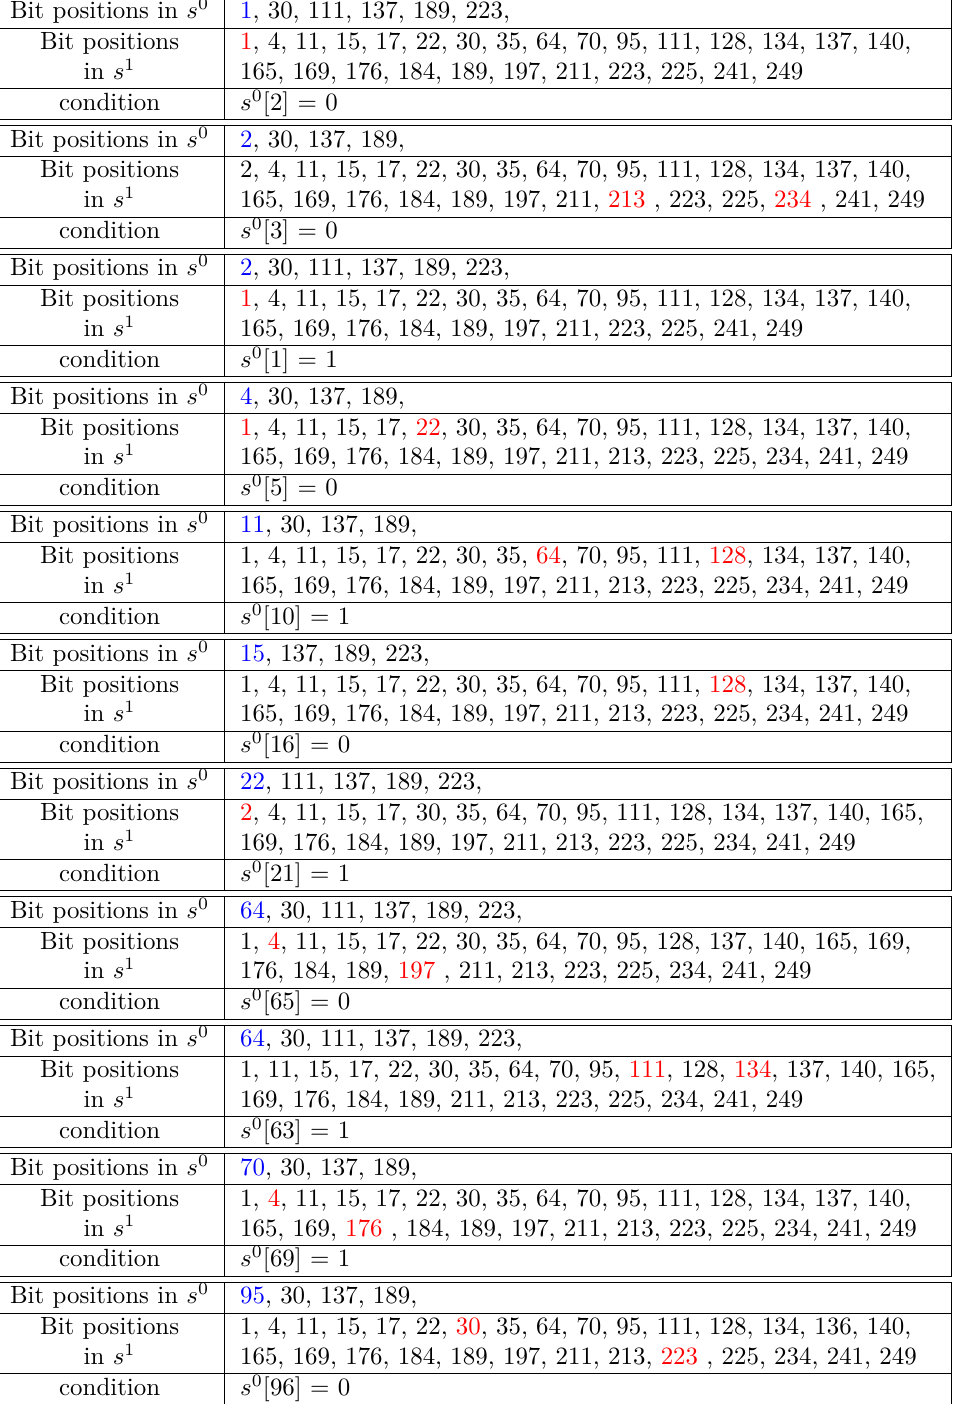
Table 10: Cube variables for conditional cube